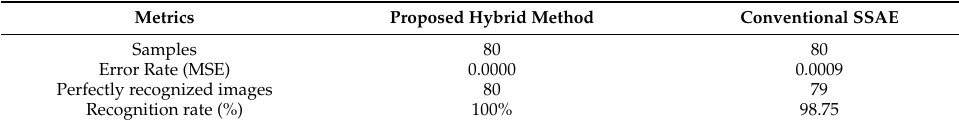
Table 5. Performance comparison for the OLR datasets.